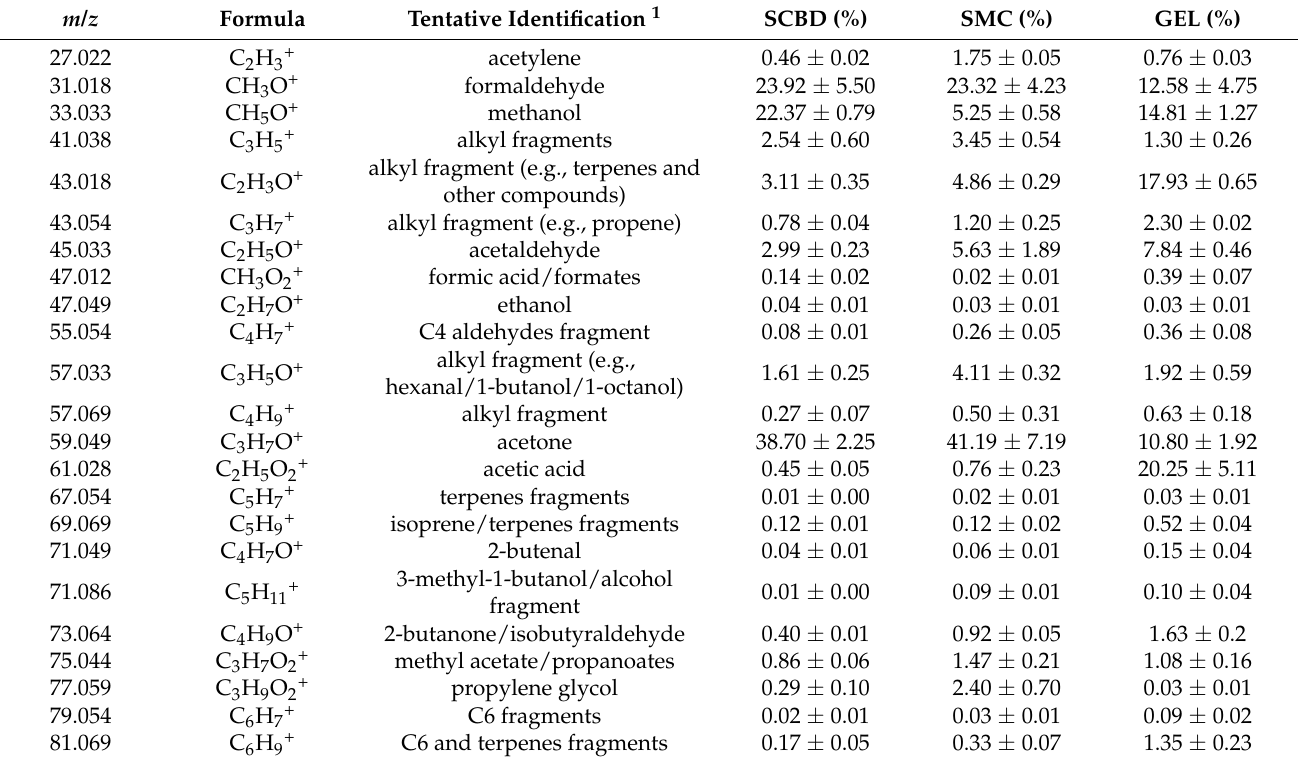
Table 3. Chemical composition (percentage emission for each m / z detected) of C. sativa pollen iden- tified via PTR-ToF-MS. Data are expressed as % on the total.